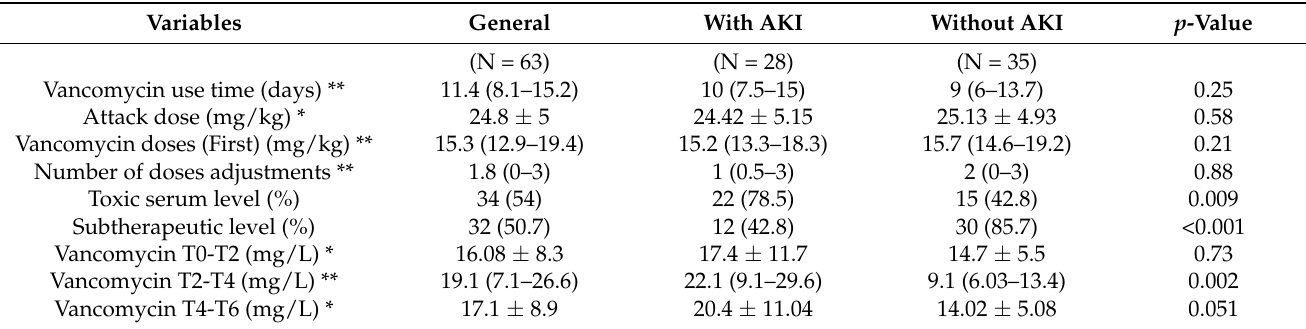
Table 2. Features related to vancomycin in patients hospitalized in an intensive care unit for the presence or absence of AKI.